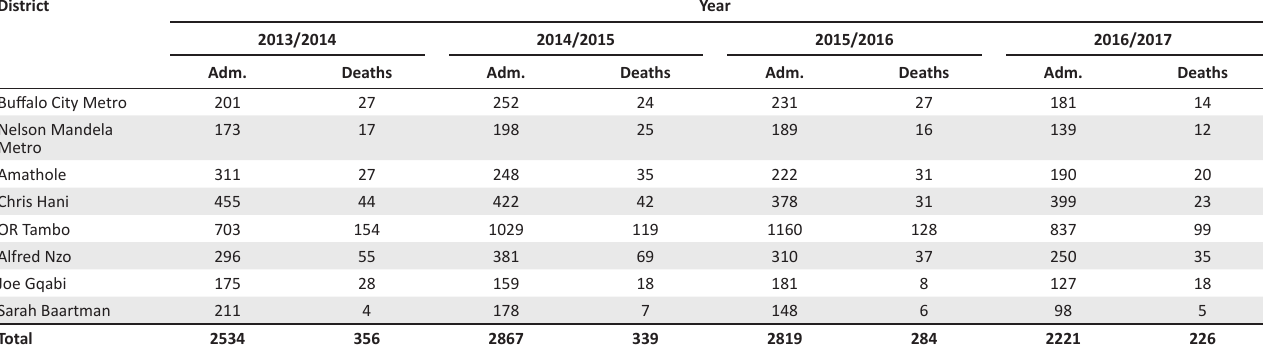
TABLE 1: Acute malnutrition deaths in the Eastern Cape hospitals from 2013 to 2017 (reported cases).